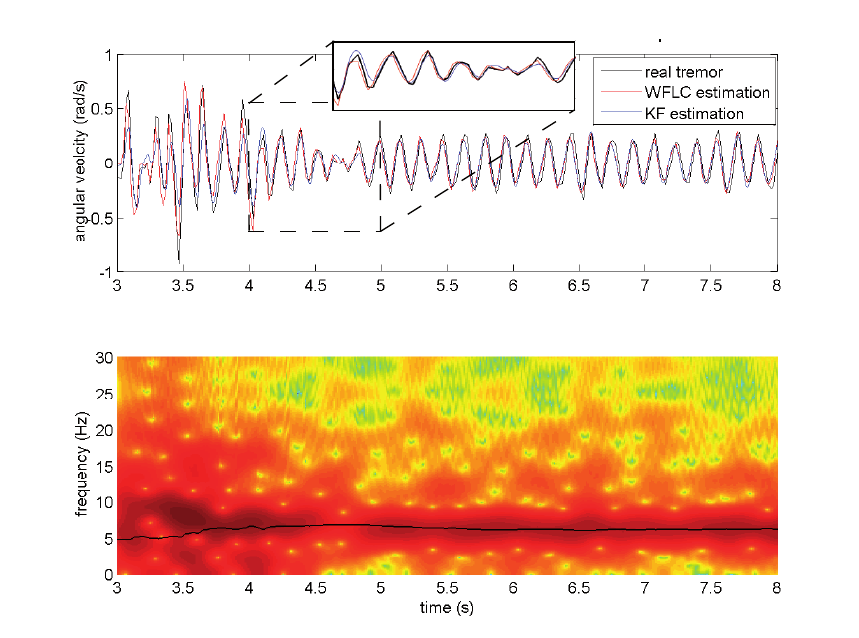
Figure 7 . Top plot: Comparison between tremor amplitude tracking with the WFLC (blue line), and a cascade algorithm compound by a KF preceded by a WFLC (red line). Bottom plot: frequency tracking with the WFLC (solid line), plotted against tremor spectrogram. Data corresponds to an arms out- stretched test performed by patient